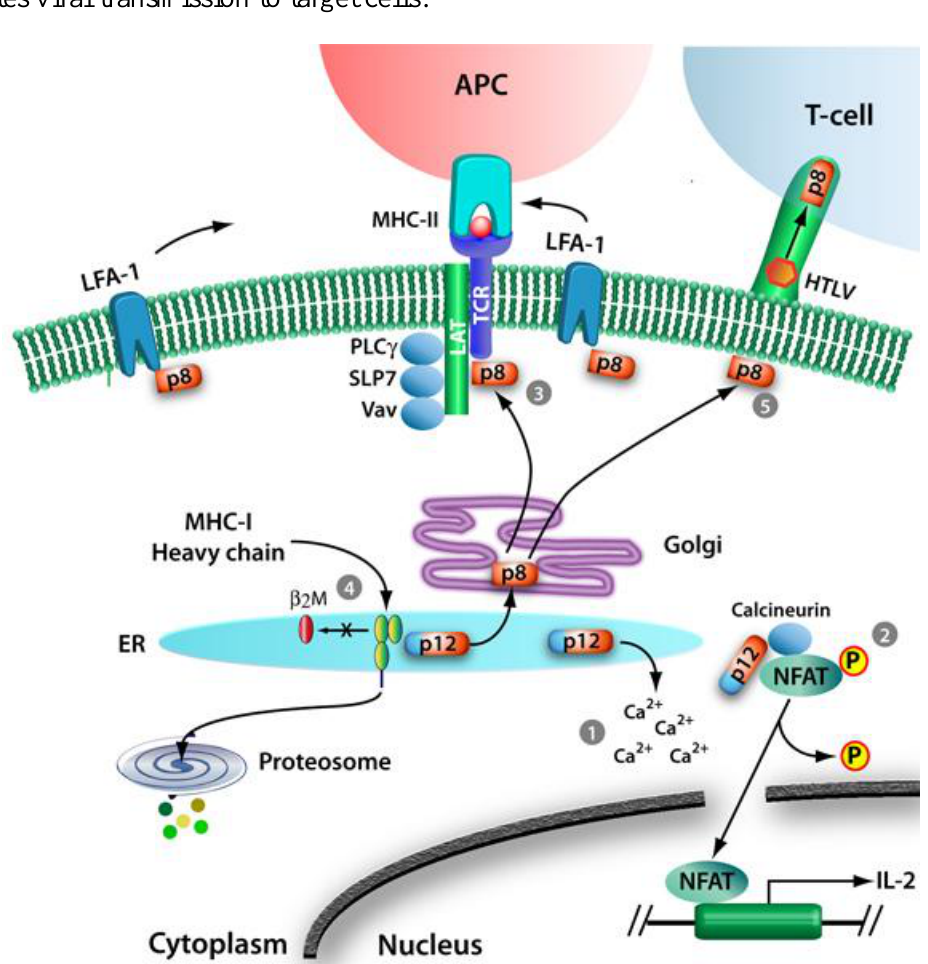
Figure 2. Functions of p12 and p8. In the ER, p12 is proteolytically cleaved at the amino terminus to generate p8, which traffics to the cell surface through the secretory